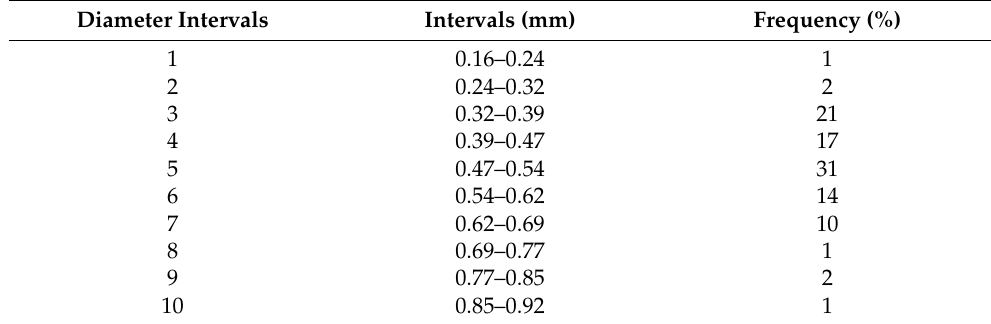
Table 1. Frequency distribution of the sedge fiber diameter.